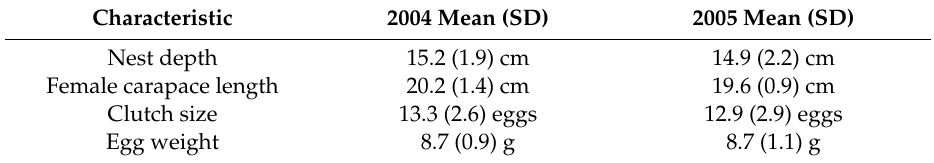
Table 1. Means and standard deviations (SD) for diamondback terrapin ( Malaclemys terrapin ) female and nest characteristics collected at Jamaica Bay Wildlife Refuge, NY in 2004 and